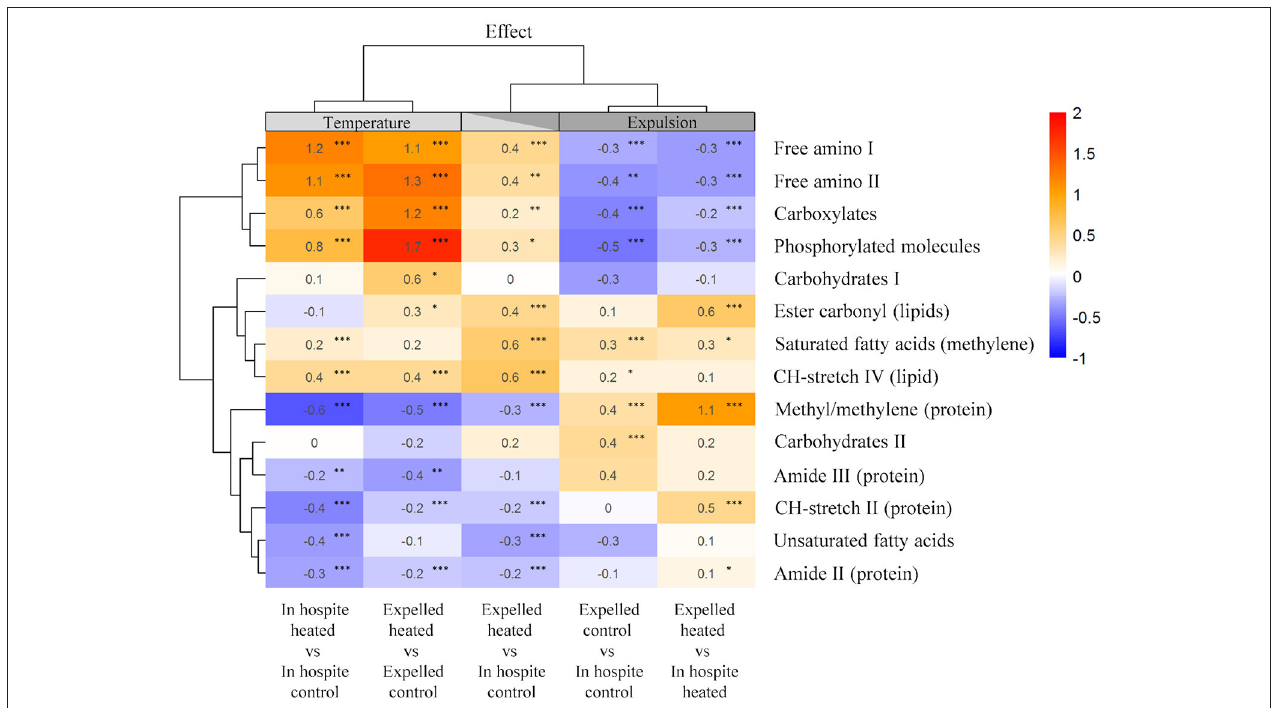
FIGURE 5 | Heat map of the mean relative changes in peak area of key biomolecules for in hospite and expelled coral symbionts compared with their respective controls. Columns are organized based on statistical clustering of temperature (LHS) and expulsion (RHS) effects, rows are grouped according to similarity of relative change in biomolecule. Numbers show the mean relative change, asterisks denote significant differences in populations from each treatment group (Kolmogorov Smirnoff test) * P < 0.05, ** P < 0.01, *** P <